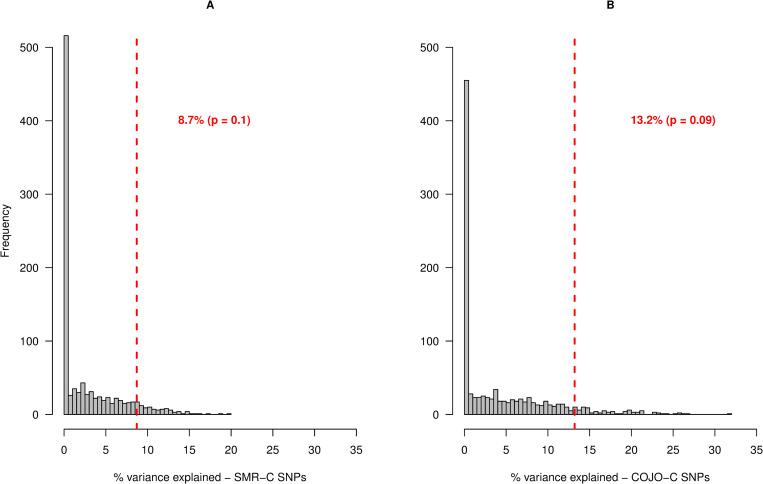
Frequency distribution of the percentage of genetic variance in New Zealand Holstein population, explained by SNPs in 1,000 control tests for COJO-C SNPs.In each test, SNPs were sampled randomly (matched by allele frequency to candidate SNPs) within a sampled gene-set (5 SNPs were sampled per gene, within each gene-set). SNPs had at least 20 copies of the minor allele in the validation population. Each sampled SNP set was used to construct the first GRM. A second GRM was made with randomly sampled 50k SNPs (excluding all SNPs in the first GRM) across the genome, to account for population structure. Figure A shows the result of control analysis for the SMR-C SNPs, in which 1,777 random SNPs in each gene set were used to construct the first GRM, while figure B shows the result of control analysis for the COJO-C SNPs, in which 5,781 random SNPs within each gene set was used to construct the first GRM. The red vertical lines represents the percentage of genetic variance explained by the candidate SMR-C and COJO-C SNPs, respectively.